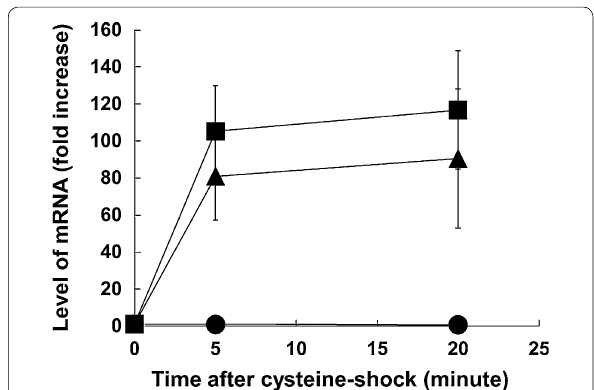
Fig. 3 Induction of yha O and yhaM transcription by cysteine. Time course of the relative yhaO ( square ), yhaM ( triangle ), and metC ( circle ) mRNA levels after the addition of cysteine (cysteine-shock). Relative mRNA levels compared with the mRNA level before cysteine addition are shown. Values represent the averages of the results based on three independent experiments and the error bar represents one standard deviation